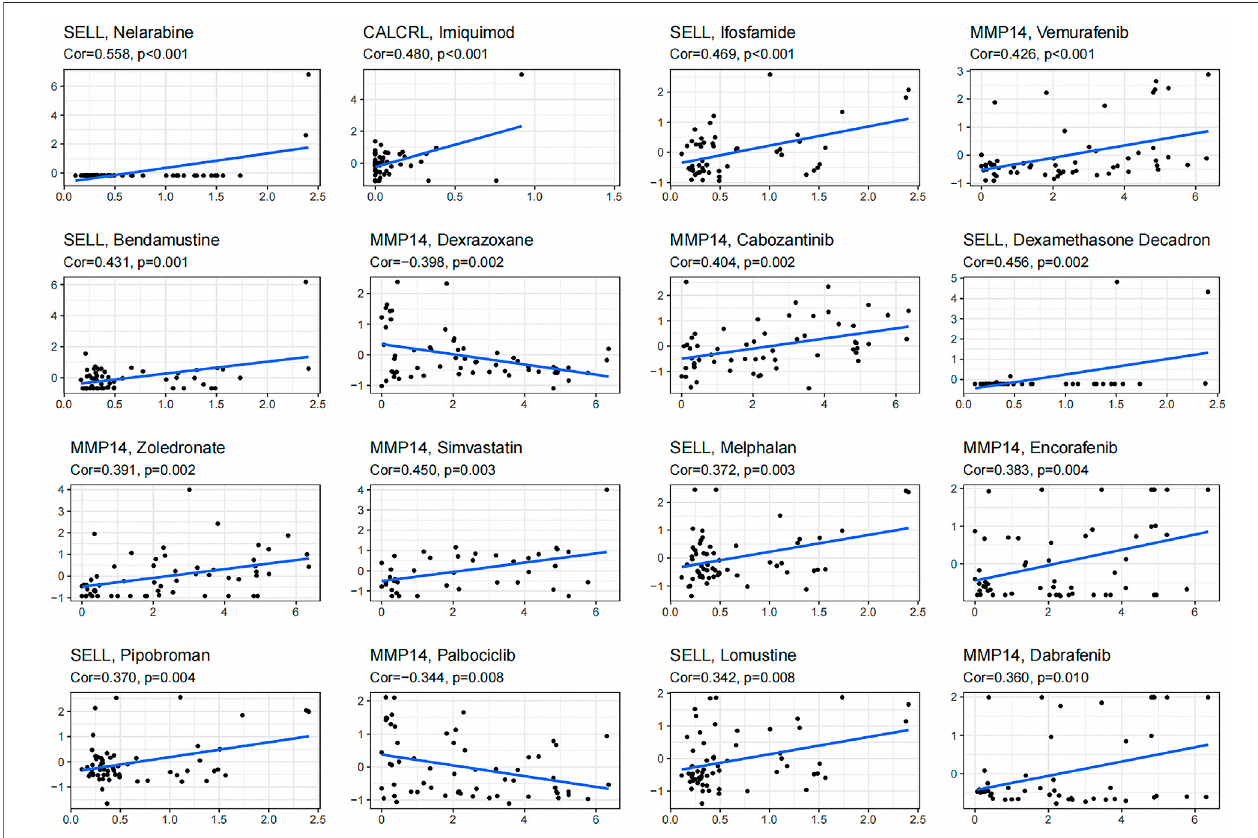
FIGURE 7 | Gene – drug sensitivity analysis based on the CellMiner database; the top 16 drugs with high correlation with gene expression in in fl ammation-related prognosis models were screened.